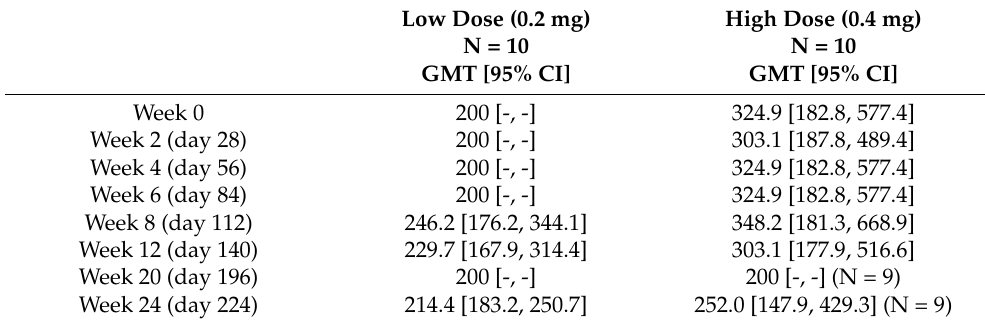
Table 3. GMT of SARS-CoV-2 S glycoprotein-specific antibody.